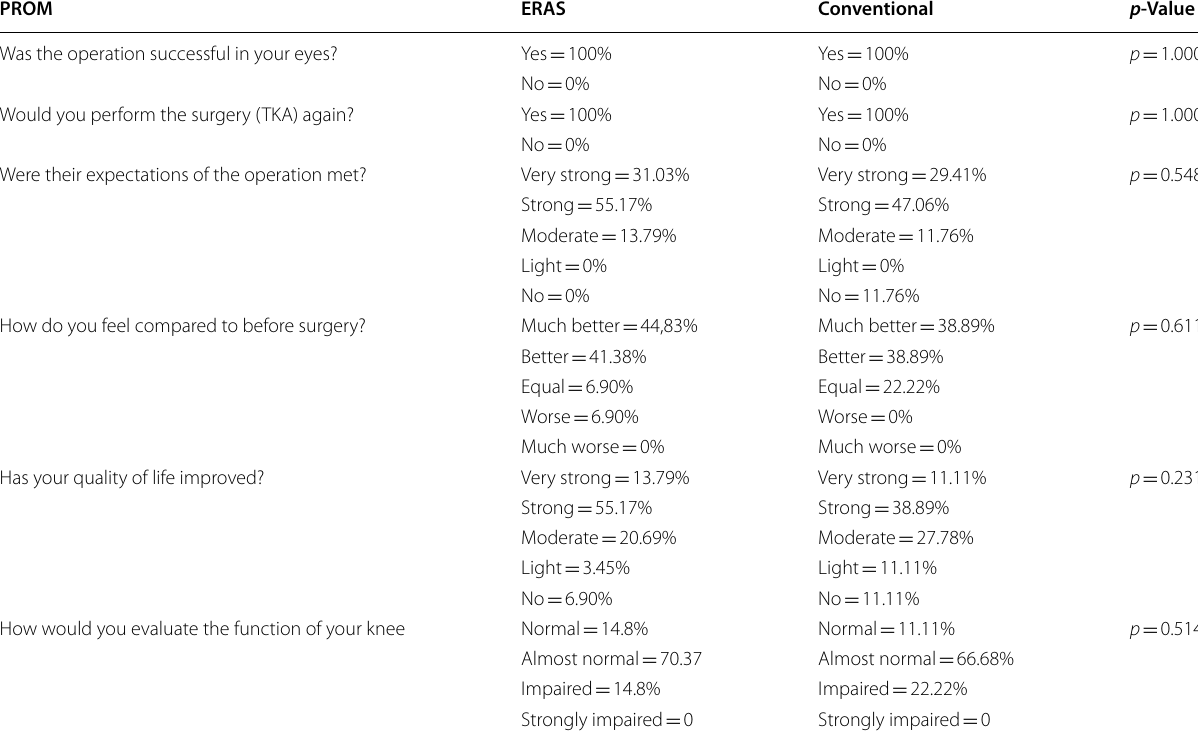
Table 5 PROMs after a follow up of 4 weeks after surgery with enhanced recovery or conventional setup PROM